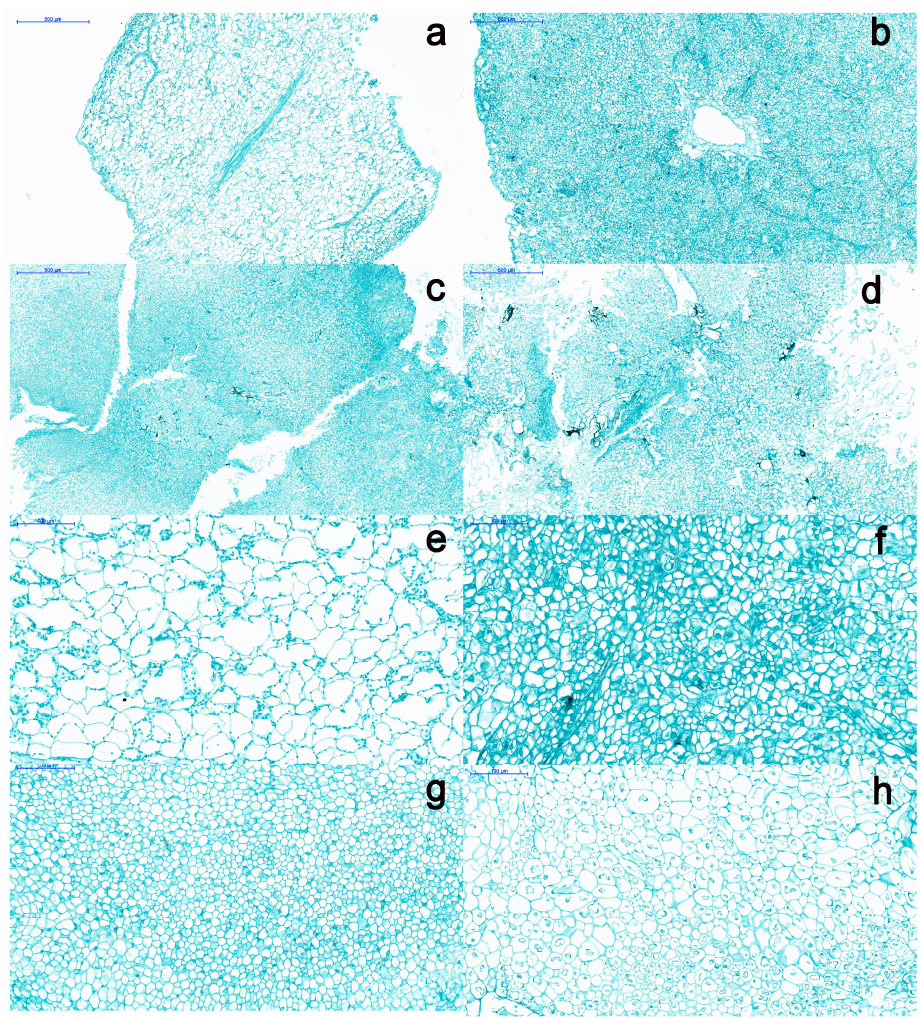
Figure 2. Morphology of somatic embryogenesis callus. ( a ) cut cotyledon; ( b ) non-embryogenic callus; ( c ) embryogenic callus; ( d ) cotyledon embryo; ( e ) Cut cotyledon; ( f ) non-embryogenic callus; ( g ) embryogenic callus, bar = 100 µ m; ( h ) cotyledon embryo.